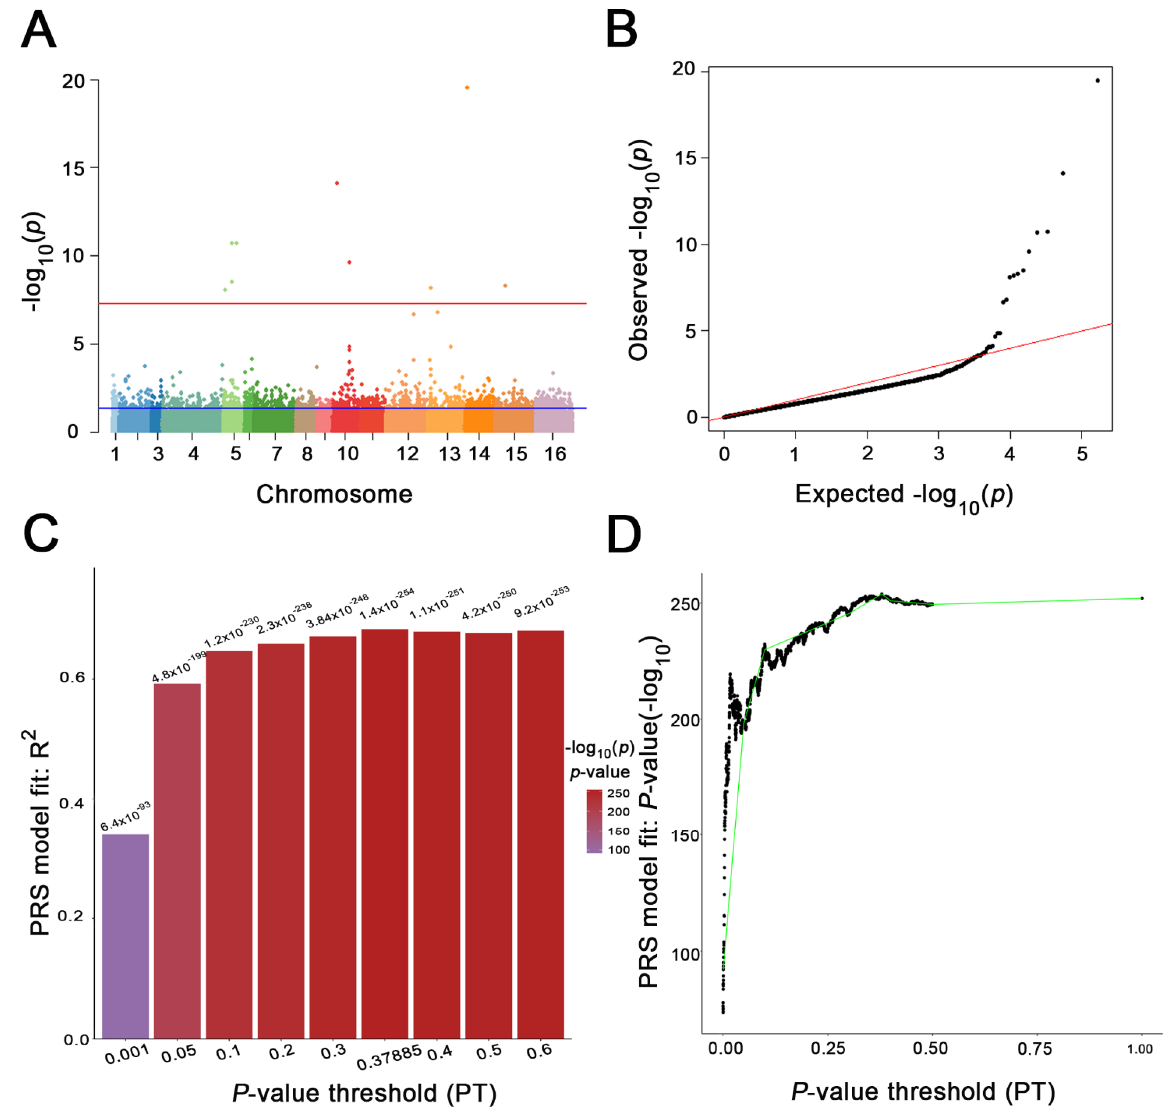
Figure 2. Genome-wide association study and polygenic risk score prediction of YPD40. ( A ) the Manhattan plot of GWAS result. The red line indicates that p -value is 5 × 10 − 8 , and the threshold is statistically significant; the blue line indicates that p -value is 0.37885, and the threshold is the precise p -value threshold ( p -value = 0.37885). ( B ) Quantile–quantile plot showing good normality. ( C ) Bar plot from PRSice-2 showing results at broad p -value thresholds for PRS predicting YPD40. A bar for the best-fit PRS from the high-resolution run is also included. ( D ) High-resolution PRSice-2 plot for PRS predictingYPD40. The thick line connects points at the broad p -value thresholds.